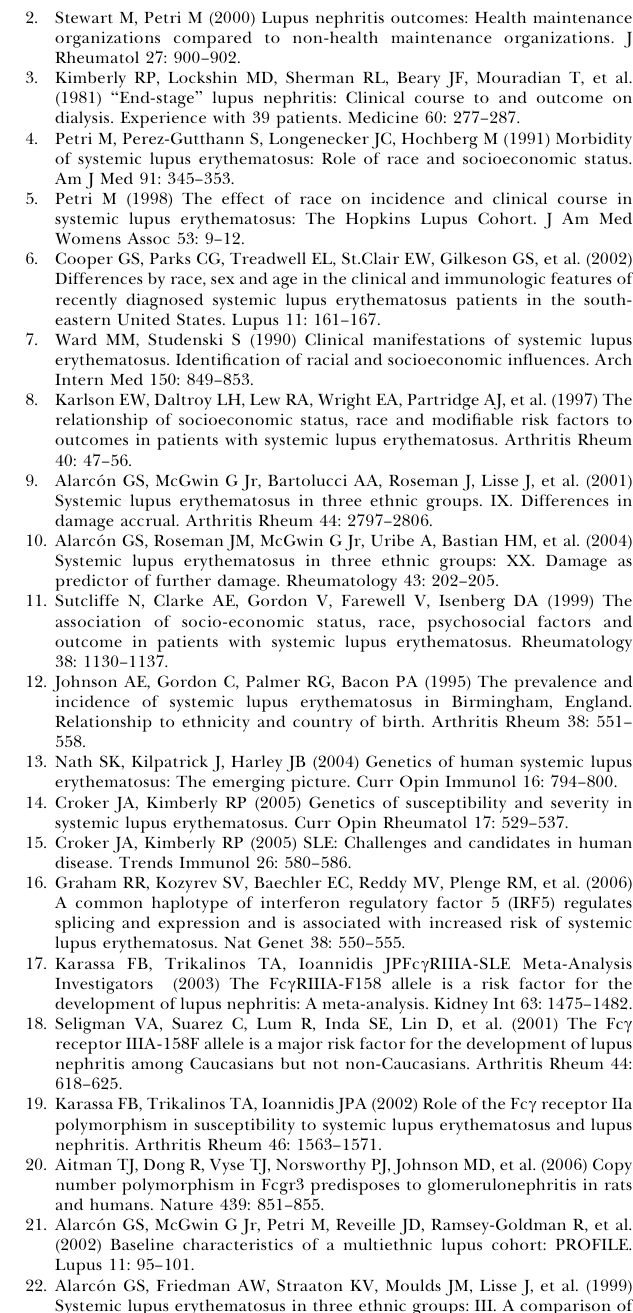
Table S1. Frequency Distribution of Selected HLA-DRB1 and HLA- DQB1 Alleles in PROFILE Patients by Ethnic Group Found at DOI: 10.1371/journal.pmed.0030396.st001 (46 KB DOC). Table S2. Frequency Distribution of the FCGR3A Alleles in PROFILE Patients as a Function of Ethnic Group Found at DOI: 10.1371/journal.pmed.0030396.st002 (39 KB DOC).